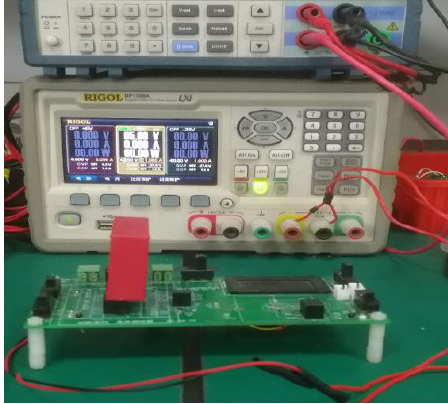
Figure 20. The diagram of testing device.